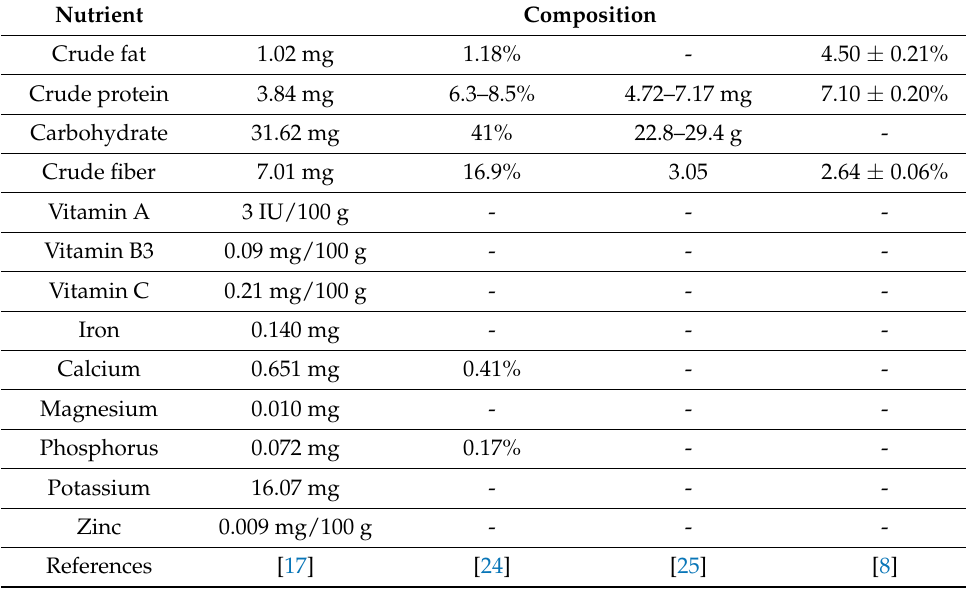
Table 1. The nutrition composition of